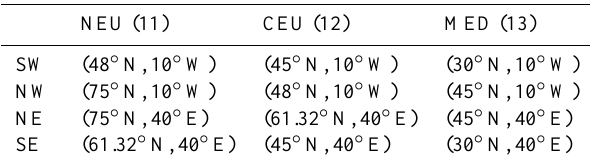
Table 1. Coordinates of European geographical zones (latitudes, longitudes) according to the SREX classification (NEU: North- ern Europe, CEU: Central Europe, MED: Mediterranean) (IPCC,